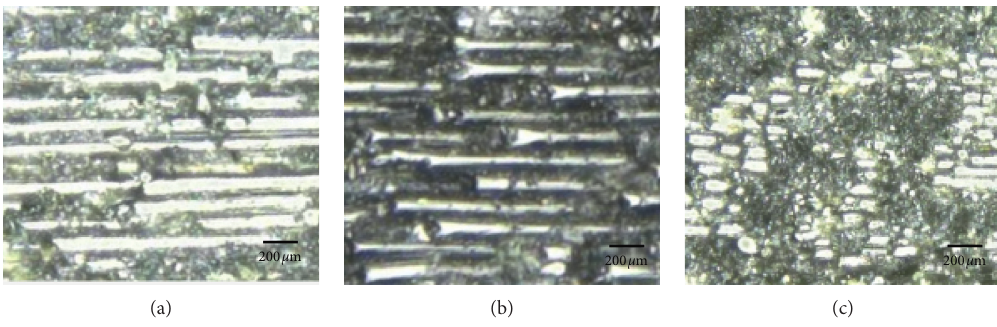
Figure 27: The feature of the hole wall at different angles.